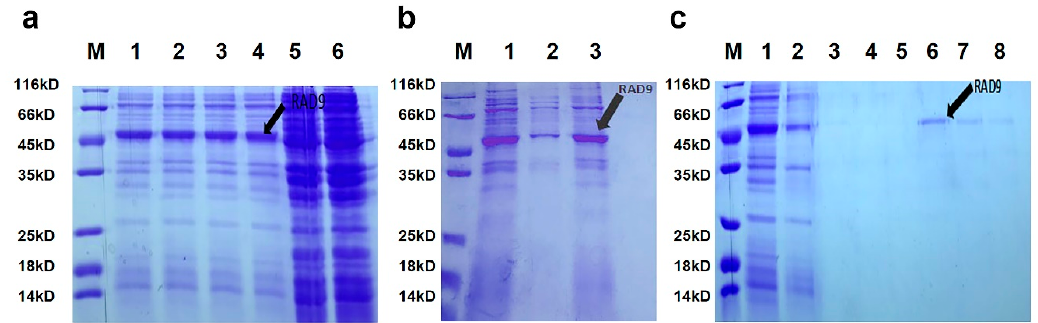
Figure 4. Expression and purification of the As –RAD9 fusion protein. ( a ) Di ff erent induction treatments of the As –RAD9 fusion protein. M: protein markers (14–116 kDa). Lanes 1–4: 1 mM IPTG at 37 ◦ C